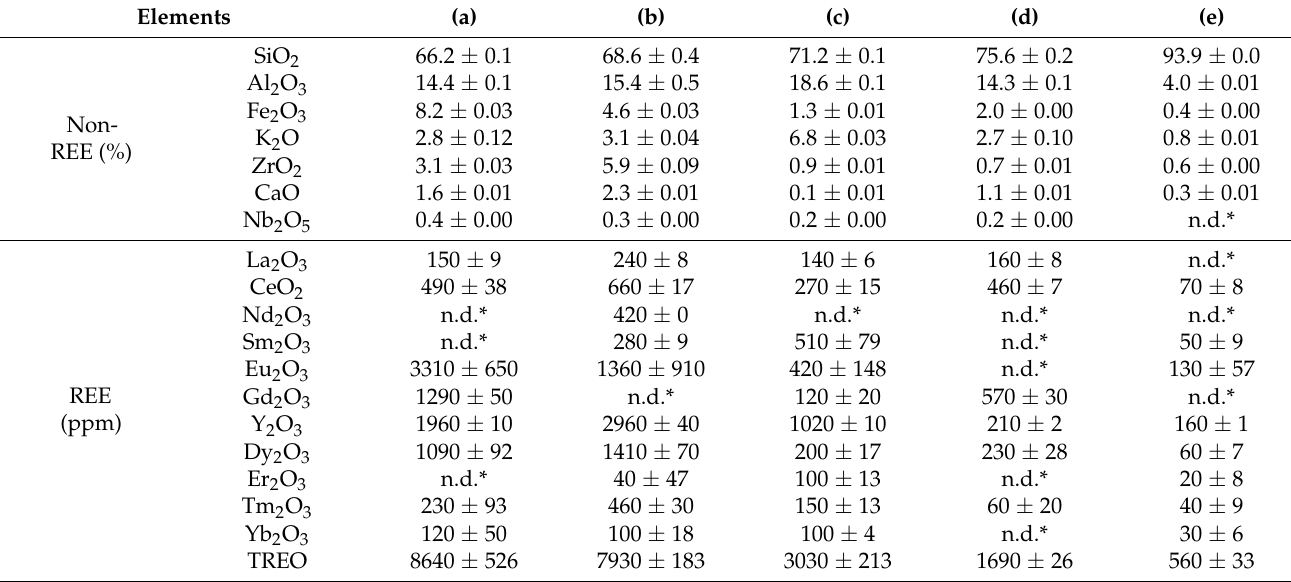
Figure 3. Photographs of samples sorted based on color: ( a ) black, ( b ) brown, ( c ) brownish yellow, ( d ) yellow, and ( e ) transparent particles. Table 2. Elemental composition of samples sorted based on color.